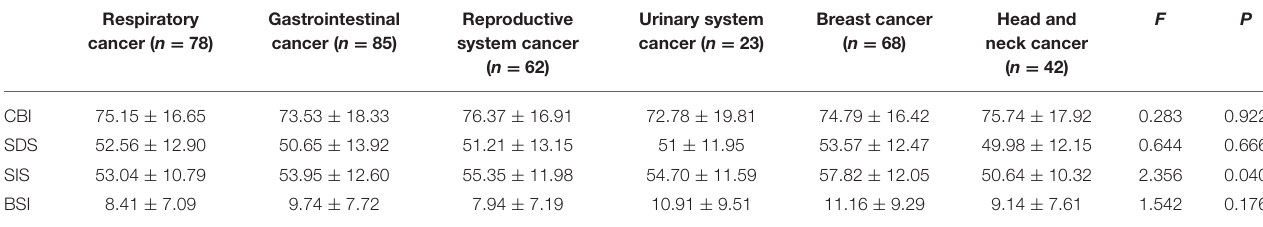
TABLE 2 | Comparison of psychological indexes of patients with different types of